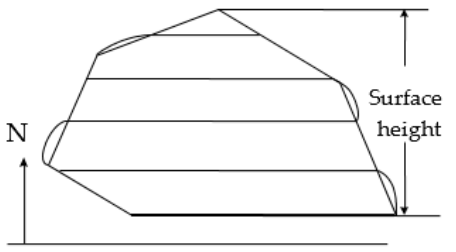
Figure 8. Relationship between Surface Height and Reciprocating Spray Time.